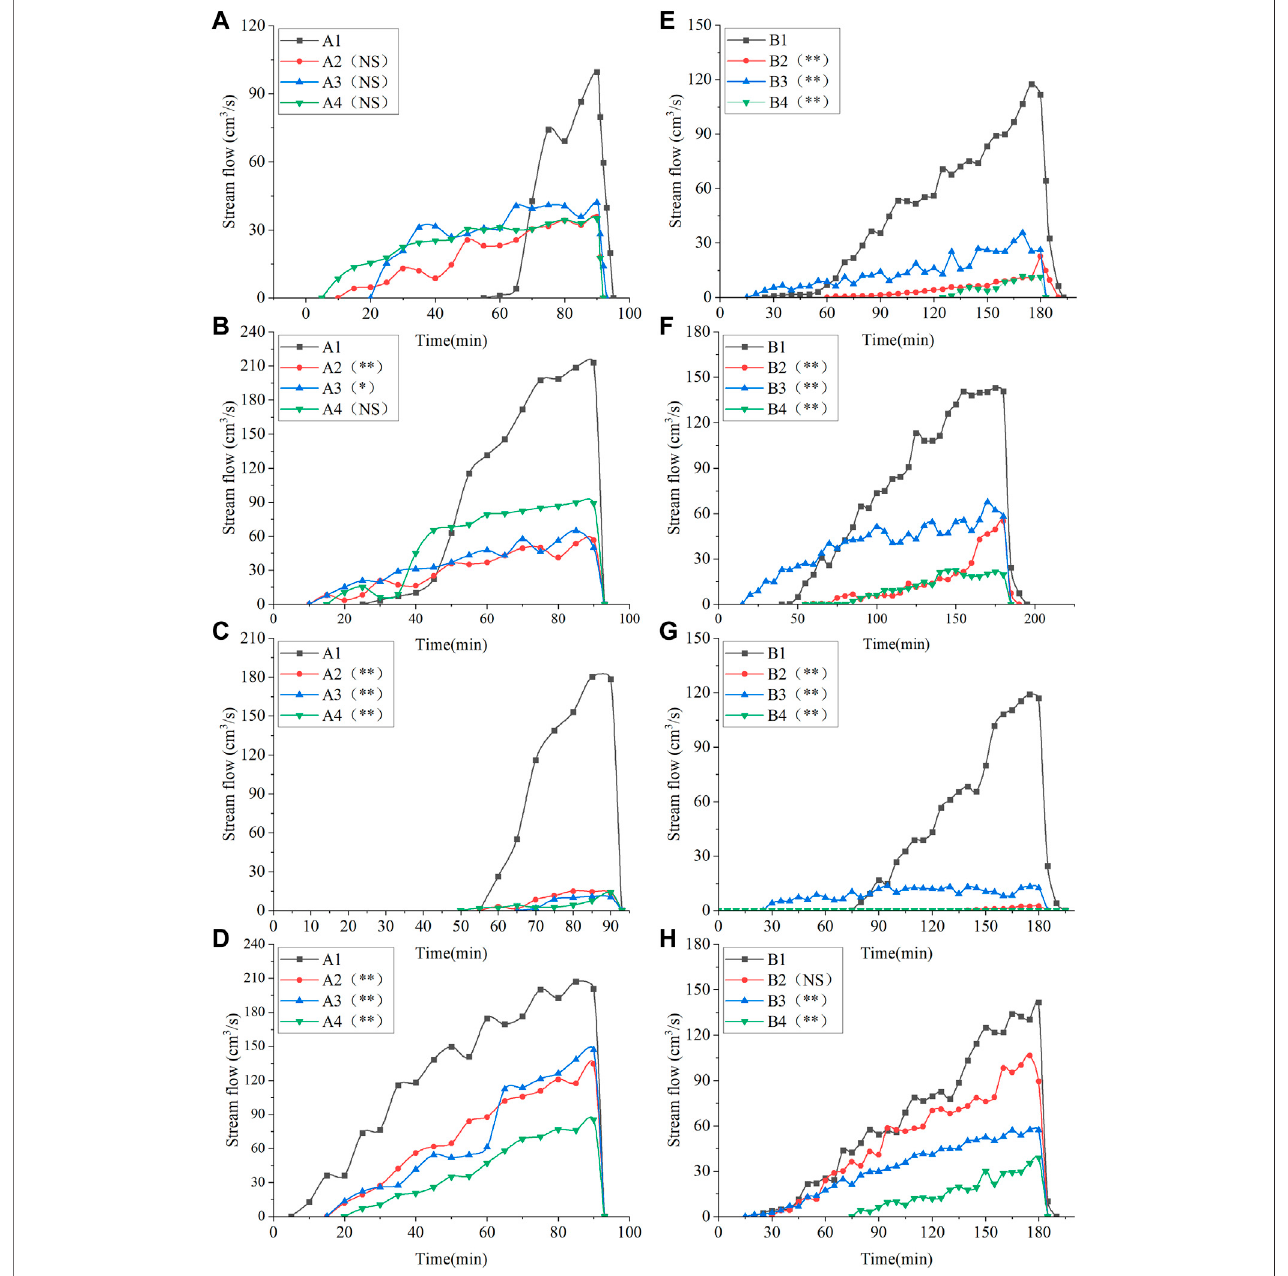
FIGURE 8 | Surface runoff process under different conditions. (A-D) The booting period, the blooming period, the grain- fi lling period, and the fallow period under 100 mm/hrainfallintensity,respectively. (E-H) Thebootingperiod,bloomingperiod,grain- fi llingperiod,andfallowperiod under50 mm/hrainfallintensity,respectively;* represents a signi fi cant difference in stream fl ow between the PFM and the control plot at α = 0.05; ** represents signi fi cant difference between the PFM and the control plots at α = 0.01; NS, no signi fi cant difference at α = 0.05.